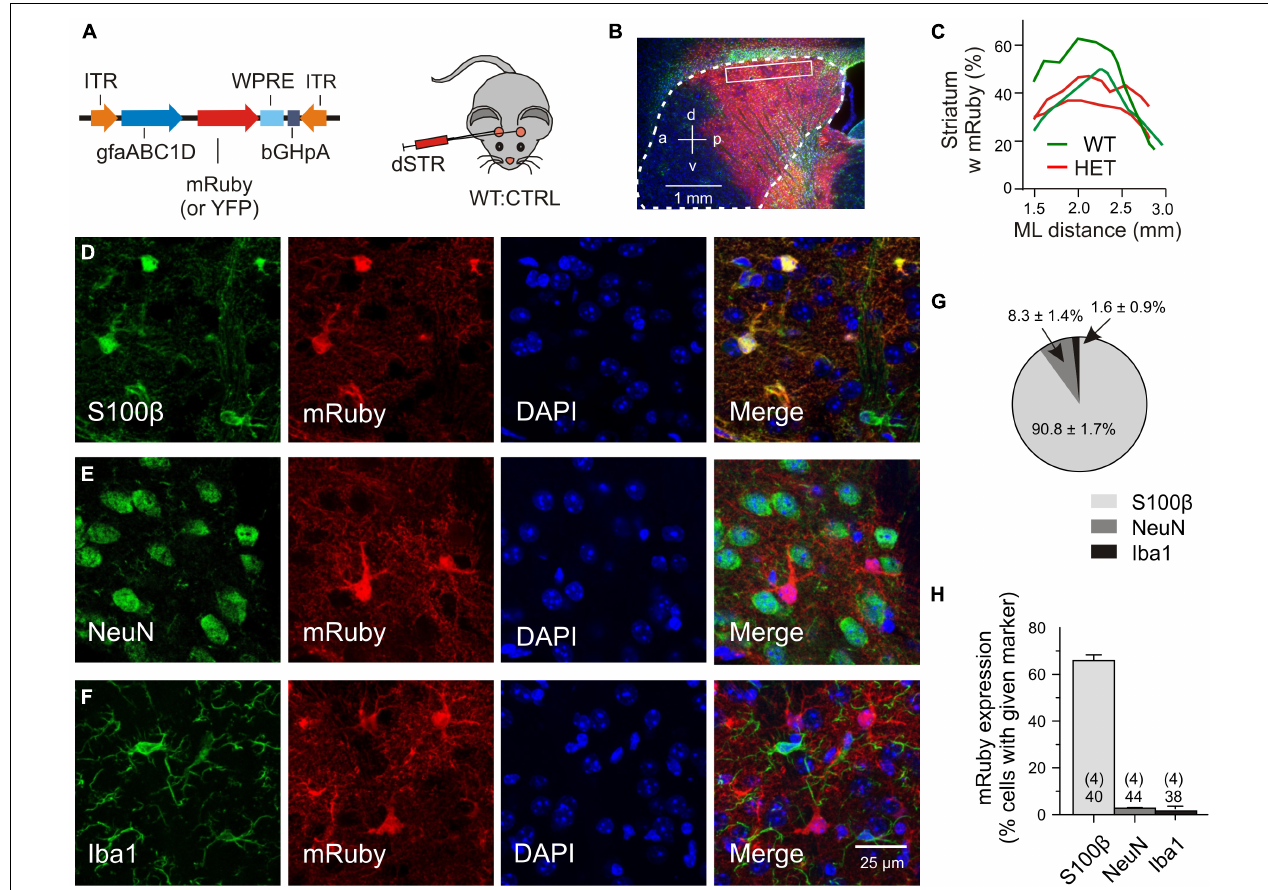
FIGURE 1 | Validation of transgene expression. (A) Injected vector. (B) Transduced area (red) visualized with mRuby on the background of DAPI (blue) and GFAP immunofluorescence (green). The putative margin of the striatum is marked with a dotted line. (C) The mRuby+ area at the indicated mediolateral distance. (D–F) Immunostained sections for evaluation of viral expression patterns. Triple labeling with representative astrocytic (D) , neuronal (E) , or microglial (F) markers, together with an antibody against mRuby and nuclear counterstaining with DAPI. (G) Fraction of the astrocytic, neuronal or microglial phenotype among the mRuby+ population in the dorsal striatum. (H) Incidence of transduced cells within the S100 β -, NeuN-, or Iba1-expressing cell populations. Numbers on columns: evaluated sections and animals (in brackets). bGHpA, bovine growth hormone polyadenylation sequence; DAPI, 4 (cid:48) ,6-diamidino-2-phenylindol; dSTR, dorsal striatum; GFAP, glial fibrillar acidic protein; gfapABC1D, modified promoter sequence of GFAP; Iba1, ionized calcium-binding adapter molecule 1; ITR, inverted terminal repeat; mRuby, monometric Ruby; NeuN, neuron-specific protein, equivalent to Fox-3, S100 β , S100 calcium-binding protein B; WPRE, woodchuck hepatitis virus post-transcriptional regulatory element; YFP, yellow fluorescent